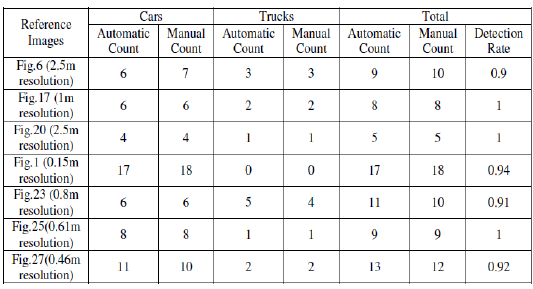
Table 1. Performance